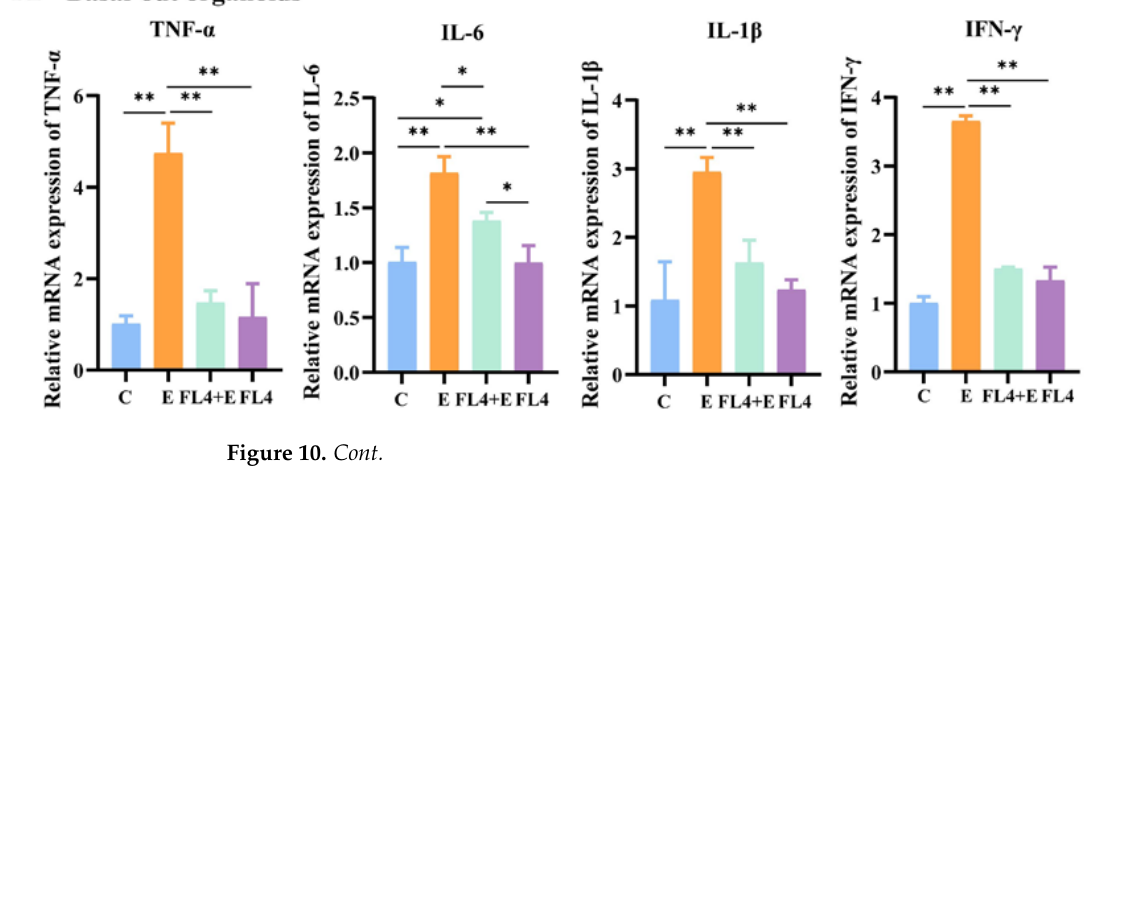
Figure 10. L. fermentum (FL4) modulated ETEC K88- induced inflammatory responses. ( A ) Expres- sion of pro- inflammatory cytokines TNF - α , IL-6, IL-1 β and IFN - γ treated with/without ETEC K88